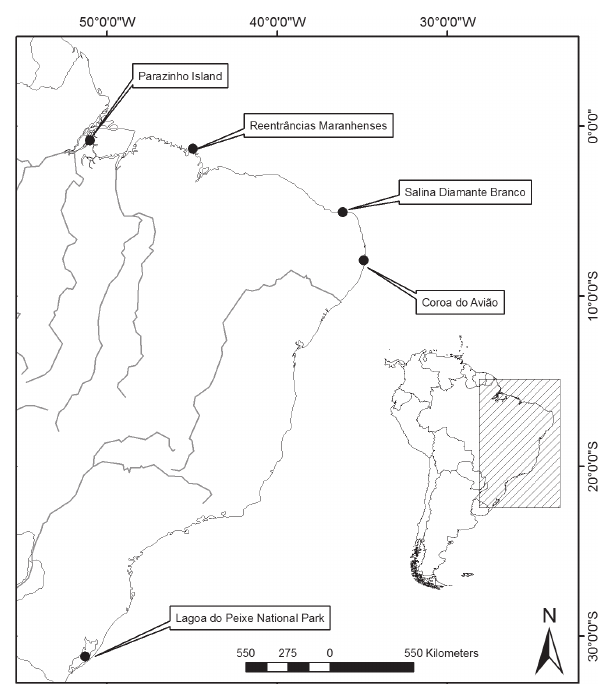
Figure 1. Traditional stopover sites along the Brazilian coast where the data-field were